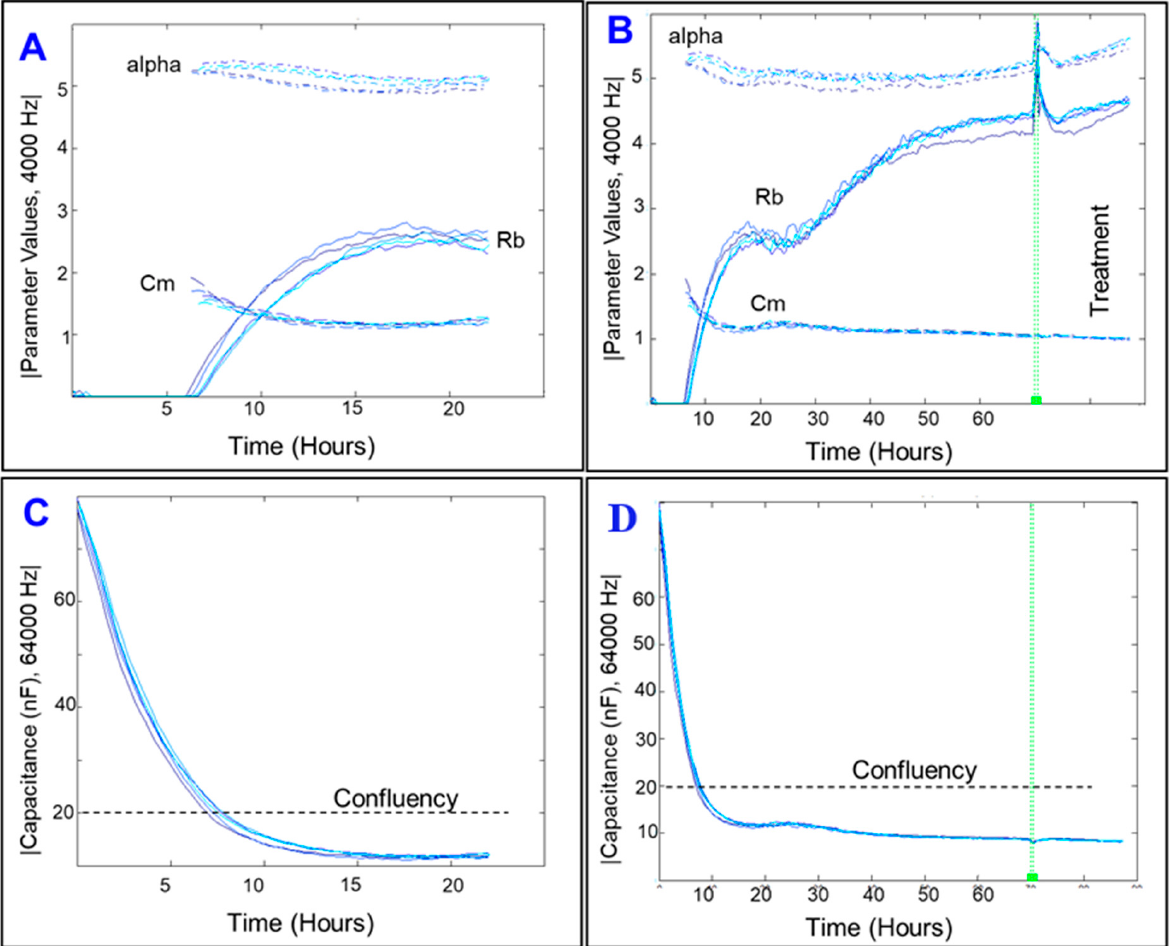
Figure 5. The ECIS models the total resistance across the ARPE-19 cells as three separate components. ( A , B ) ARPE-19 cells achieved a stable α resistance as well as Cm and formed a confluent monolayer much before they achieved a stable Rb resistance. The basolateral adhesion of the ARPE-19 cells to the gelatin basement layer ( α ) was established first and was maximal by ~5 h followed by formation of monolayer by ~8 h as indicated by reaching a plateau in the Capacitance spectrum measured at 64,000 Hz. However, Rb values did not begin to model until ~5 h after the ARPE-19 cells were cultured and reached a maximum at ~60 h later ( C ), where ARPE-19 cells still have a confluent monolayer ( D ). These results indicate that for this specific cell line, a monolayer has formed early, but a functional barrier is not present until ~50 to 60 h after seeding. The green line here represents changing to serum free medium before initiating the treatment. We see in this extended time frame ( C ), that Rb did not maintain the plateau it reached in as seen in ( A ) and instead continues to climb until around T = 60 h. However, α and Cm are steady from T = 20 h until green line. Capacitance is seen to maintain that steady minimum from T = 20 h until green line ( C , D ).